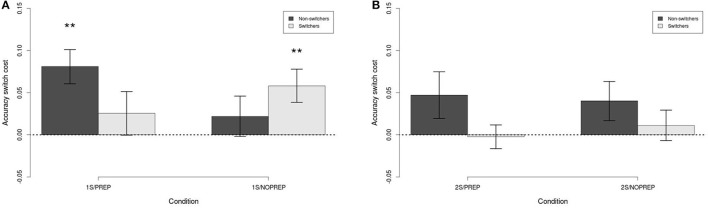
Accuracy switch cost in each condition. (A) Block 6 in 1-session conditions. (B) Block 13 in 2-sessions conditions. Error bars are between-subject standard error of the mean. **p < 0.01.